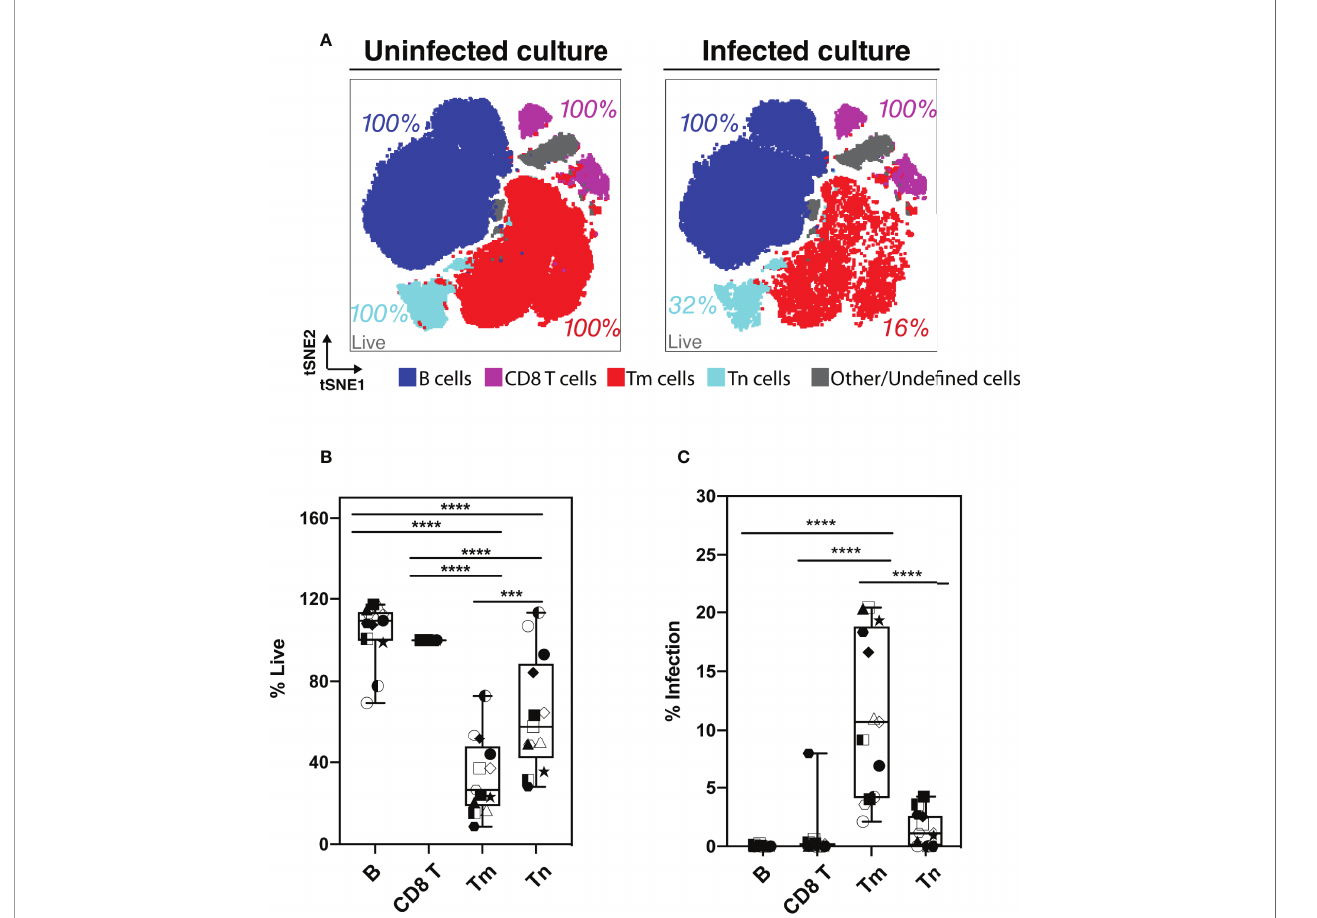
FIGURE 3 | Assessment of preferential killing and infection of main subsets of HLAC cells (B, CD8T, CD4 T memory, and CD4 T naïve cells). (A) tSNE plots of total HLAC cells from uninfected culture (left panel), and HIV infected culture (right panel). HLAC cells were classi fi ed and colored by main subsets including B (CD19+) (dark blue), CD8 T (CD3+CD8+) (purple), Tm (CD3+CD4+CD45RO+CD45RA-) (red), Tn (CD3+CD4+CD45RO-CD45RA+) (light blue), and Other/ Unde fi ned (CD19-CD3-, gray). These subsets were de fi ned using FlowSOM and cell surface marker expression ( Figure S4 ). Live cell percentage (% live) in each subset were calculated as described in the Materials and Methods, and are labeled beside each cell subset. Preceding parent gates are indicated at the lower left corner. (B, C) Proportions of live (B) and infected (C) cells among B, CD8 T, Tm, and Tn cells from 6 donors, calculated as described in Materials and Methods. Symbols represents technical repeats from 6 donors. Each donor is represented as a shape with technical repeats represented with different type of fi ll (details described in Materials and Methods). ***p ≤ 0.001; ****p ≤ 0.0001; no label: not signi fi cant, p > 0.05 . Signi fi cance was measured by one-way ANOVA with repeated measurements followed by post-hoc tests (n = total paired-wise comparisons). Paired effect between Tm and Tn is shown by estimation plots in Figure S8